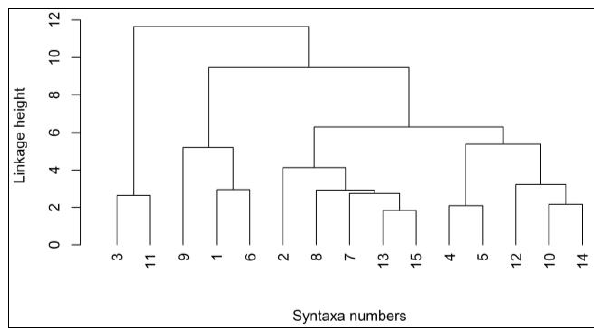
Fig. 4. Assessment of the degree of similarity of biotope conditions for the syntaxa formation of the vegetation of afforestation belts (according to their phytoindicational